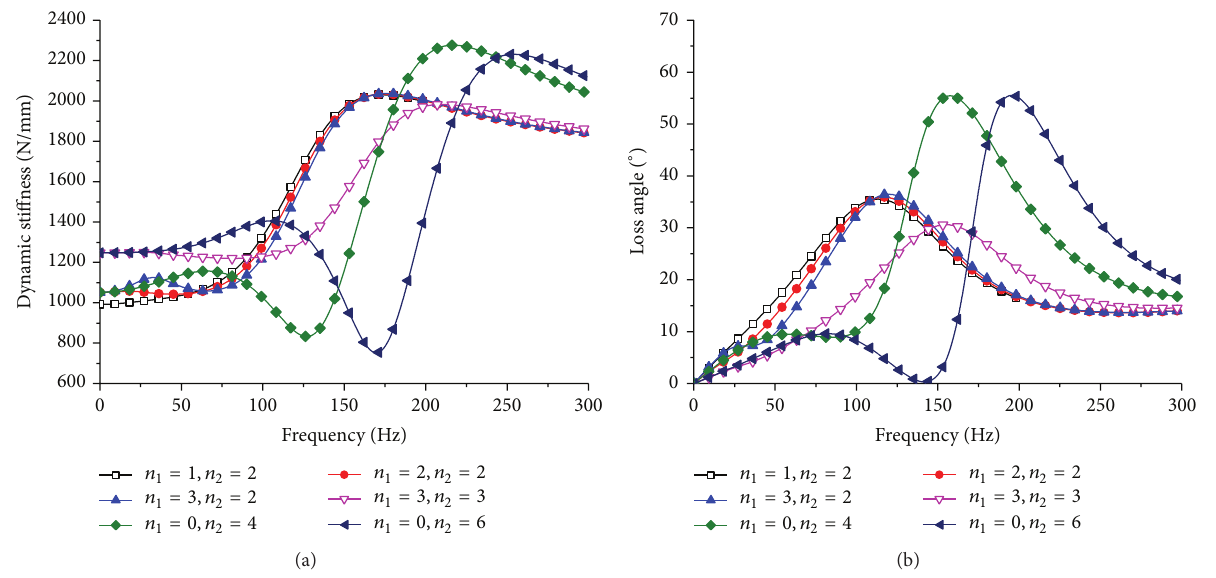
Figure 13: Calculated results of the dynamic characteristics of HDB with multiple tracks. (a) Dynamic stiffness. (b) Loss angle.